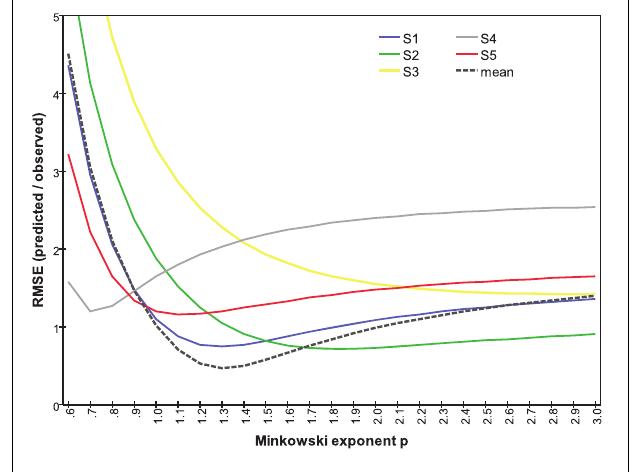
FIGURE 9 | RMSE between predicted and observed dissimilarities as a function of Minkowski exponent p , for all observations (solid line), for subset of smaller observations predicted from (cid:2) mn and (cid:2) ab less than mean value (gray line); for subset of larger observations predicted from (cid:2) mn and (cid:2) ab greater than mean value (dashed line).